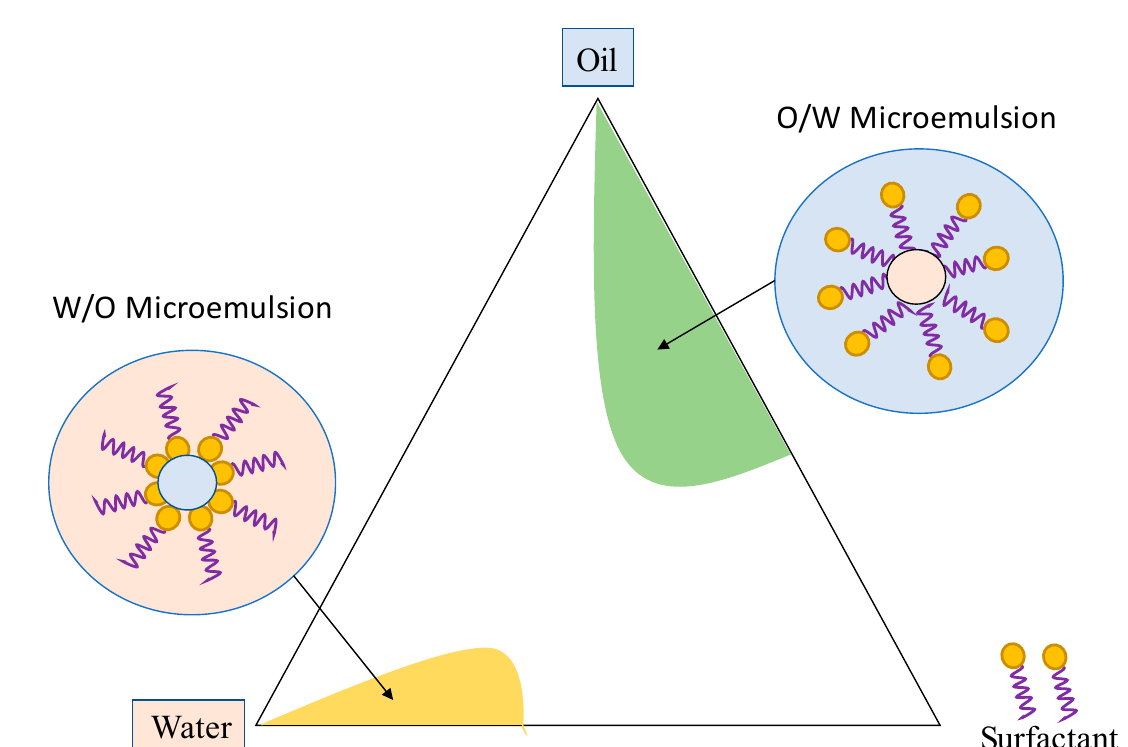
Figure 2. Diagram of a ternary phase of an O/W/surfactant system.